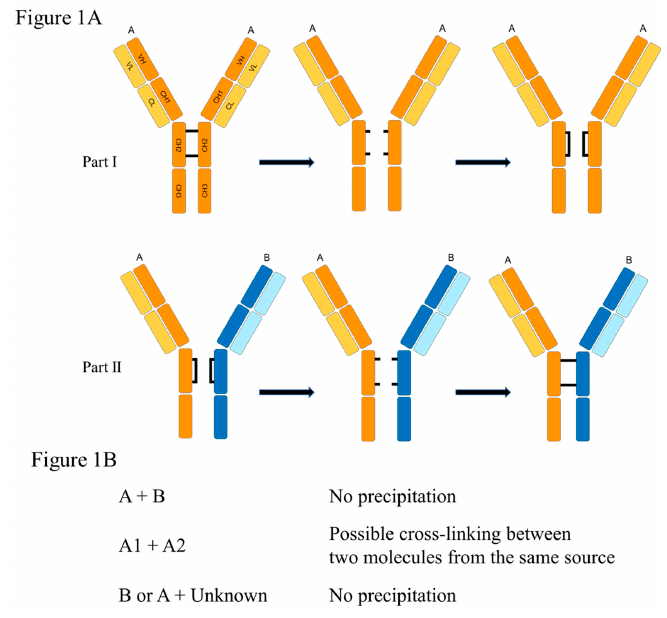
Figure 1. ( A ) Fab-arm exchange in IgG4 molecule. The separation of the two arms depends on the ability to create stable disulfide bonds within each arm (Part I); the recombination with other arms is random (Part II). ( B ) We propose that the quantities of the three forms of the recombined mole- cules depends on the quantity of specific IgG4 antibodies in the